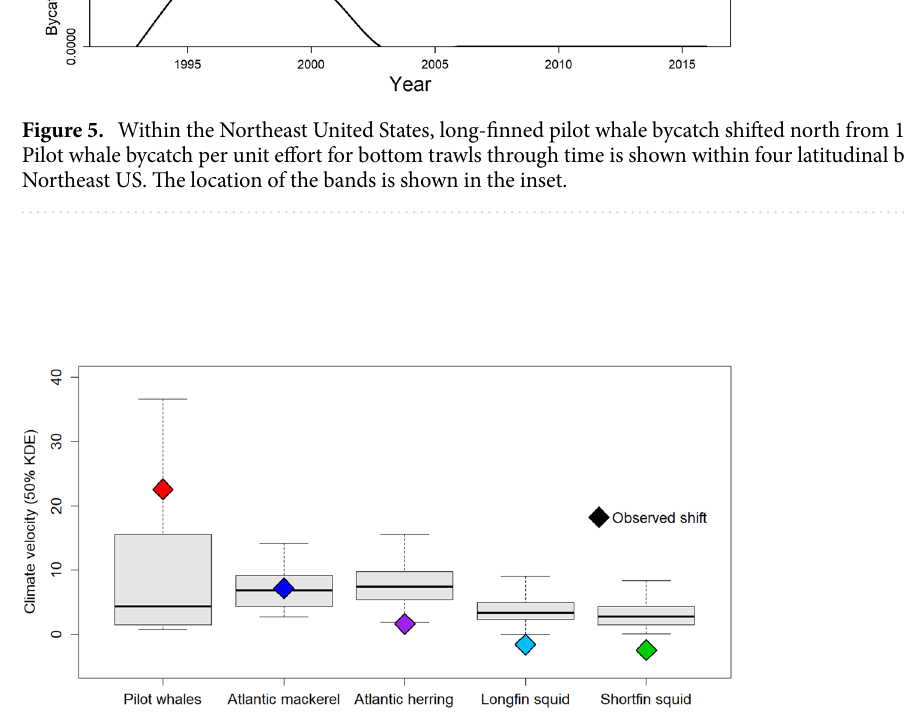
Figure 6. Climate velocity (km/year) within the core habitat of long-finned pilot whales, Atlantic mackerel, Atlantic herring, longfin squid and shortfin squid. Colored diamonds represent observed poleward shifts for each species. Pilot whales shifted faster than expected based on climate velocity in their habitat, while Atlantic mackerel shifted approximately as expected and Atlantic herring, longfin squid, and shortfin squid shifted less than